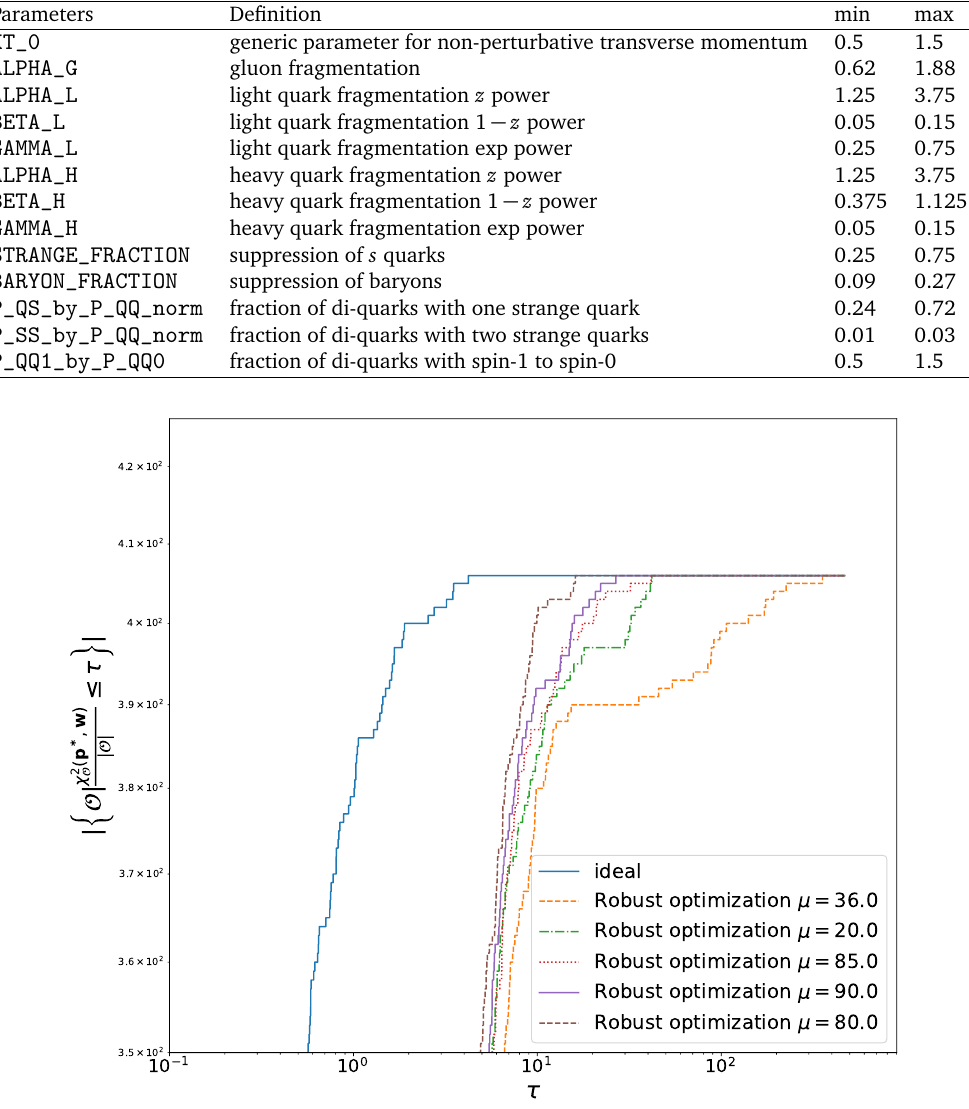
Figure 11: Ideal cumulative density curve and the cumulative density curves of robust optimization runs with selected hyperparameter values µ for the A14